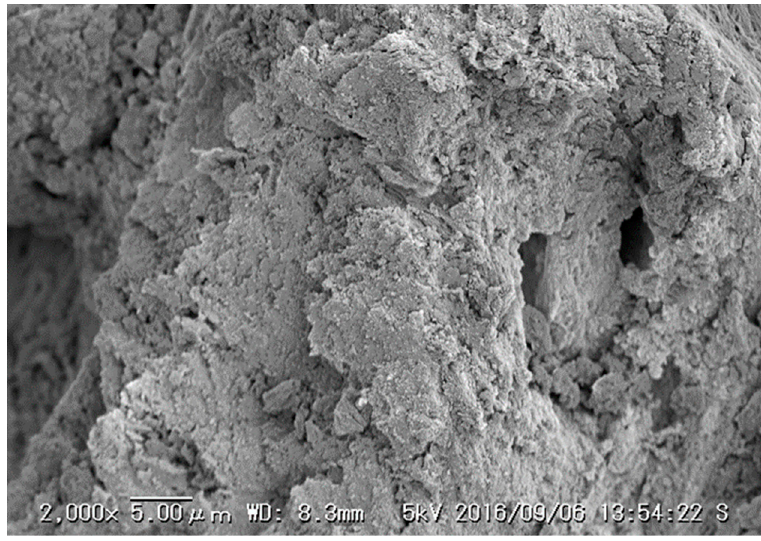
Figure 6. SEM image of the CBC before fluoride adsorption.